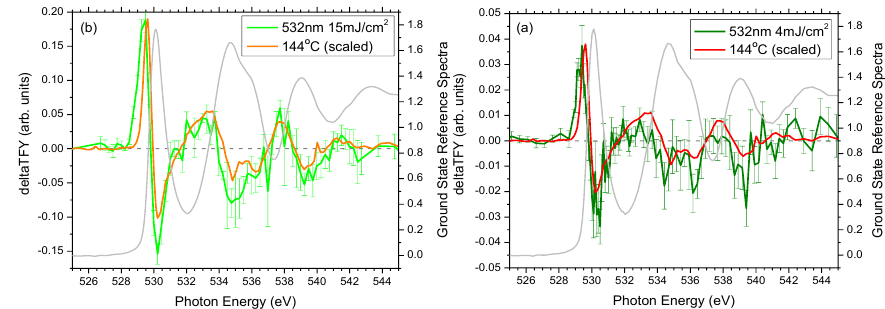
Fig. 2. Photoinduced tr-XAS difference spectra of CuO (green, left axes) recorded 150 ps after excitation with 532 nm pulses at intensities of a) 4 mJ/cm 2 and b) 15 mJ/cm 2 . The spectra are compared to the difference between quasi-static XAS spectra recorded at room temperature and 144 ºC, scaled to the same maxima as the tr-XAS signals (red). The ground state XAS spectrum of CuO is shown in gray (right